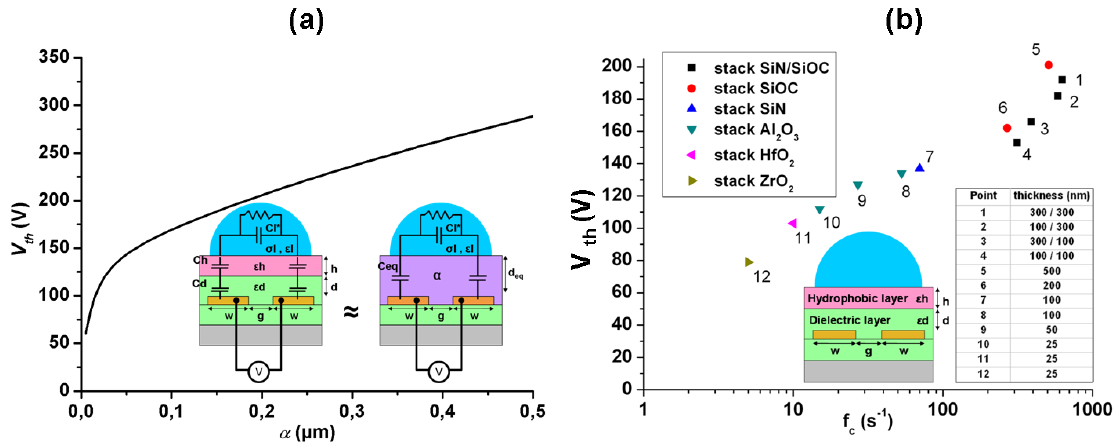
= 6 × 10 −6 S m −1 , ε =80 , w/g = 20 / 10 µm , f = 10 f liq liq O , HfO and ZrO are respectively 6.3, 2.75, 8, 12 and 2 3 2 2